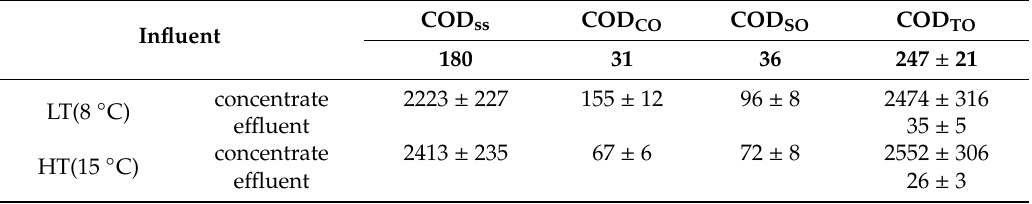
Table 1. Classified COD concentration of influent, concentrate, and e ffl uent. Unit: mg /